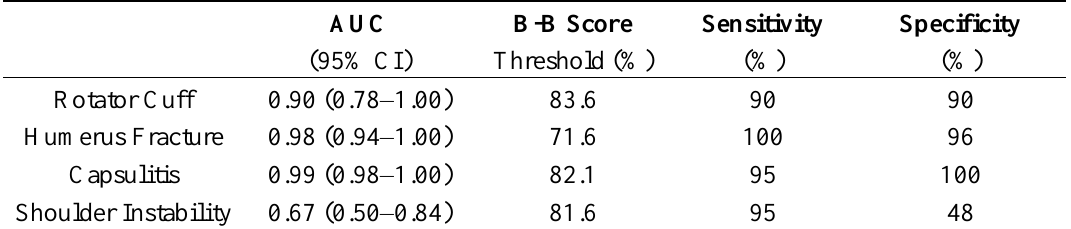
Table 4. ROC curve analysis results for classifying pathologies.